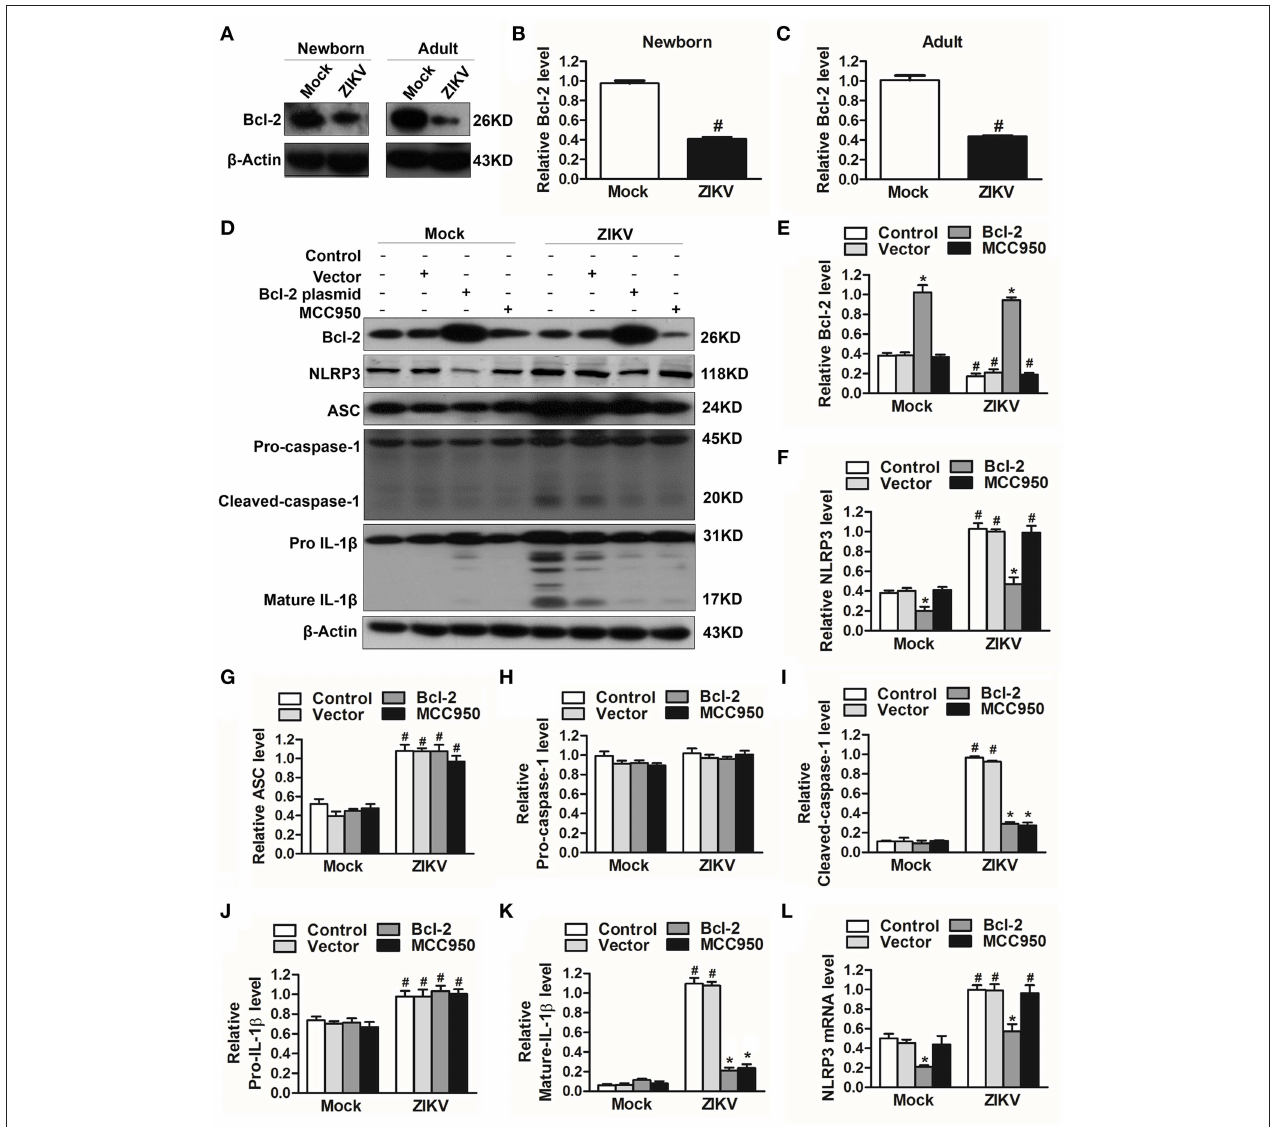
FIGURE 7 | Overexpression of Bcl-2 attenuated ZIKV-induced NLRP3 inflammasome activation in HK-2 cells. (A–C) Expression level of Bcl-2 in the kidneys of newborn (A,B) and adult mice (A,C) at 7 days post-infection were assessed by western blot. (D–K) HK-2 cells were transfected with control vector or pSG5-FLAG-Bcl-2 plasmid (2 µ g/ml) for 24h or pre-treated with MCC950 (10 µ M) for 30min followed by incubation with PBS (mock group) or ZIKV (MOI = 2), and cultured with complete medium in presence of MCC950 or PBS at 37 ◦ C for 24h. The protein expression levels of Bcl-2, NLRP3, ASC,